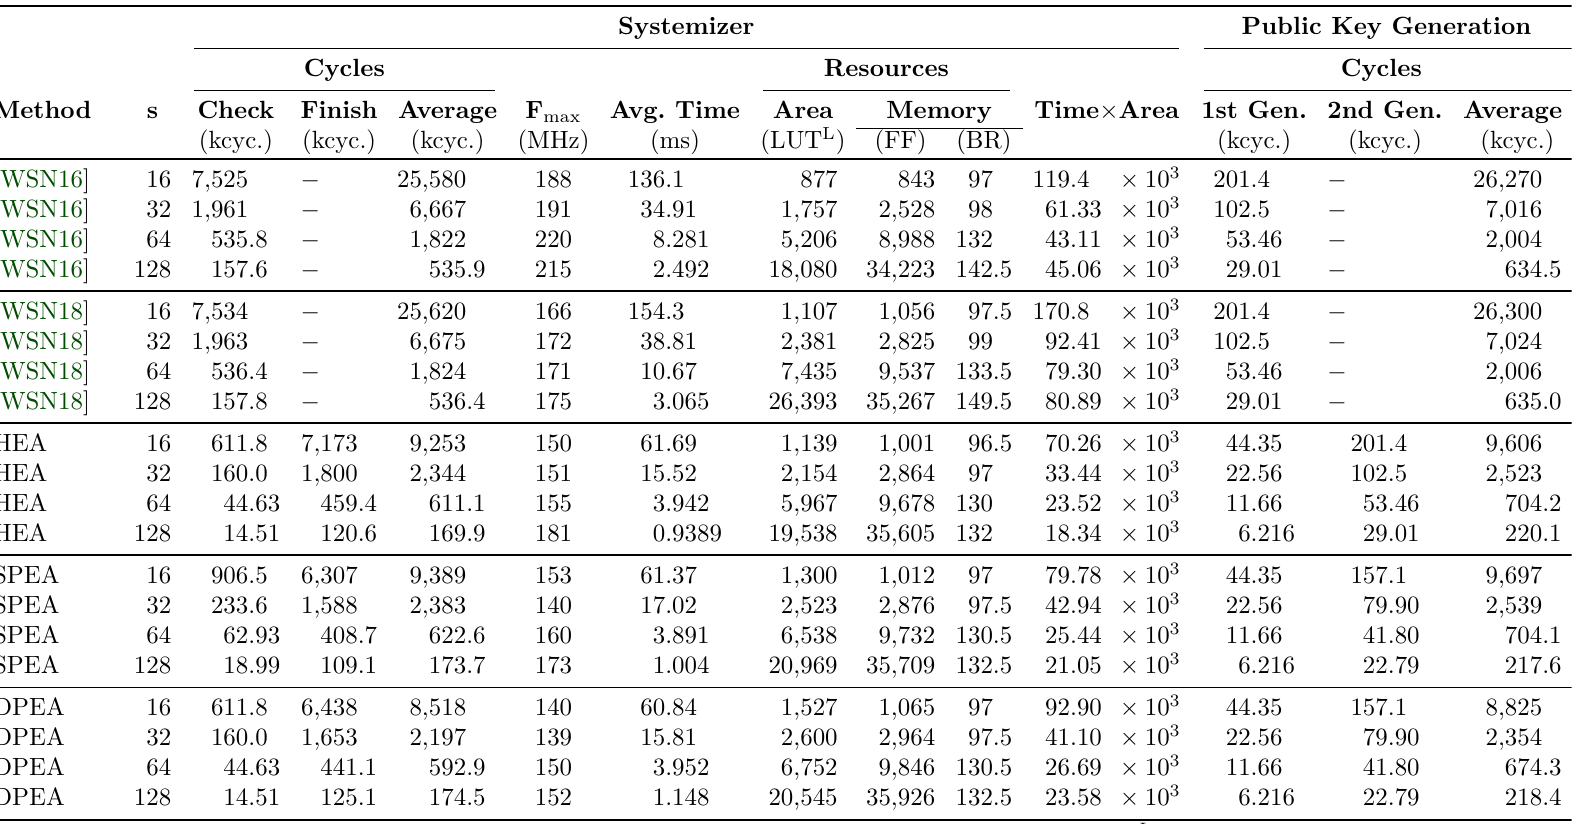
Table 4: Performance of the F 2 systemizer for the mceliece348864 parameter set with a 768 × 3488 matrix “Time × Area” are rounded to four significant figures. Cycles are given in kilocycles (kcyc.). Resources are for a Xilinx Artix 7 FPGA